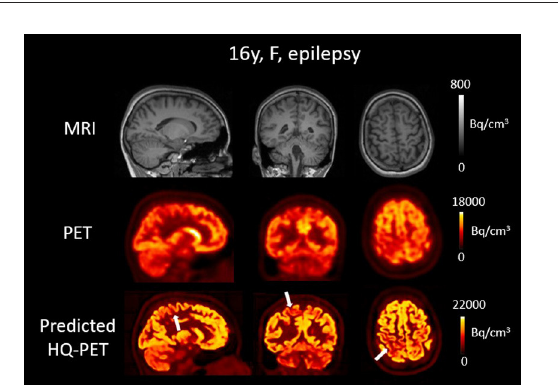
FIGURE8 Brain T1w MRI and clinical [ 18 F]FDG PET as well as predicted high-quality (HQ) PET (predicted by the network developed in this work) from one patient with drug-resistant epilepsy. Images are displayed using radiological conventions (subject’s left on the right) and white arrows are used to highlight areas of hypometabolism. The first two rows show images from the scanner and the third row shows the AI-enhanced high-quality PET. MRI depicted a blurred white matter gray matter border in the right postcentral gyrus. The PET showed a correlated blurred and mild hypometabolism extending toward the precuneus. The predicted HQ PET showed a clearer hypometabolism very well correlated with the lesion that also extended to the precuneus. Bq, Becquerel cm 3 : centimetres cubed